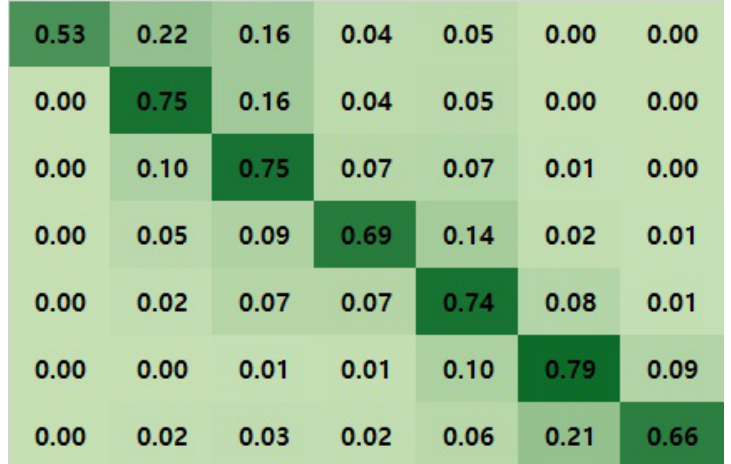
Figure 1. The confusion matrix for (k-Nearest Neighbor) k-NN.